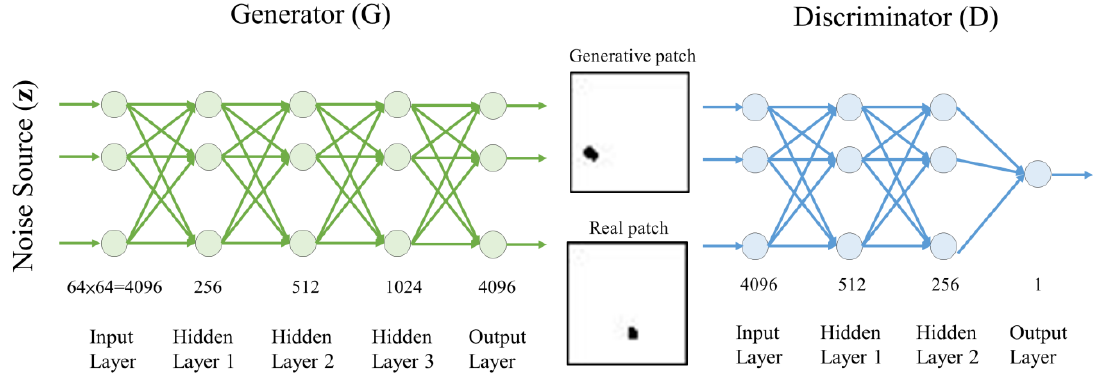
Figure A1. Architecture of the GAN network.